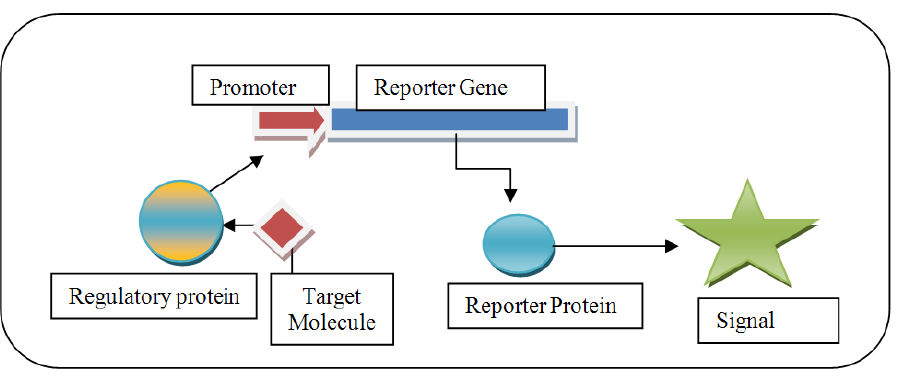
Figure 1. Graphic illustrating the concept of a whole-cell transcriptional